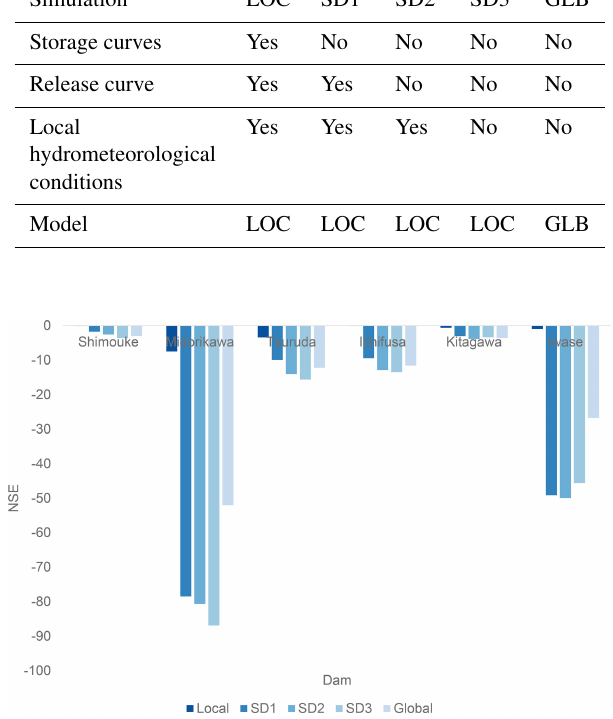
Figure E1. Sensitivity analysis for reservoir storage. See Table E1 for the simulation